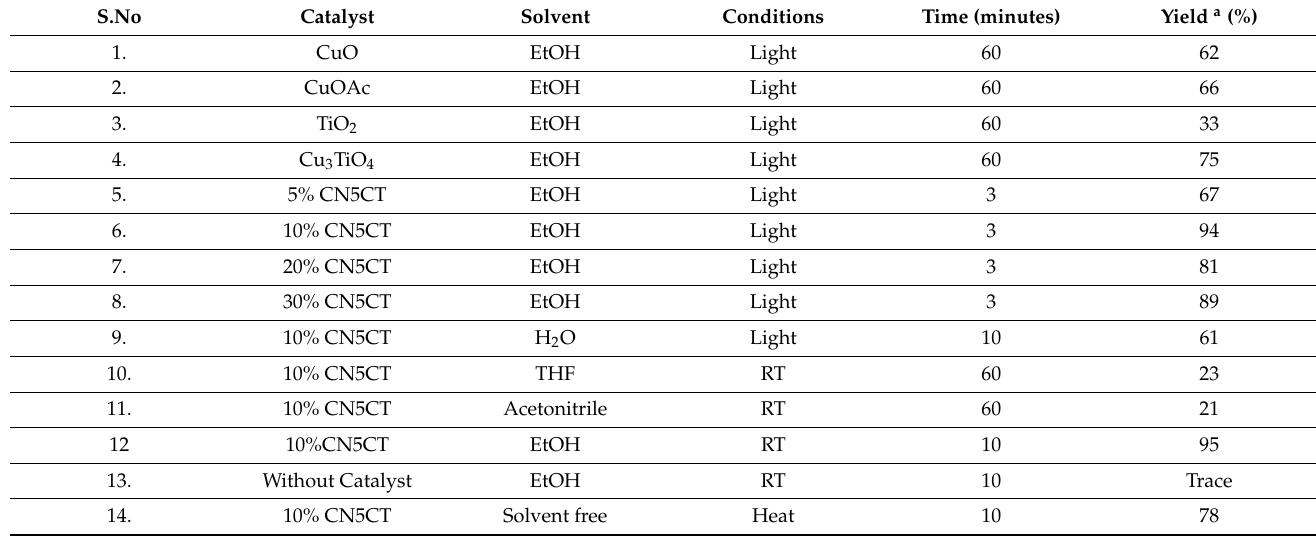
Table 1. Optimization for the synthesis of Carbonitriles in BLUE LED visible